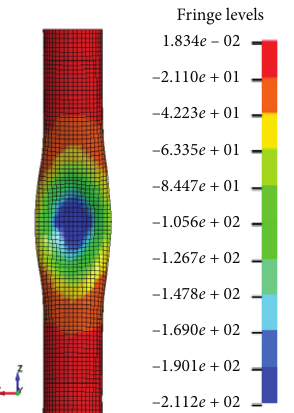
Figure 11: Result of simulation for CFDST column (scaled distance � 0.14m/kg 1/3 ).